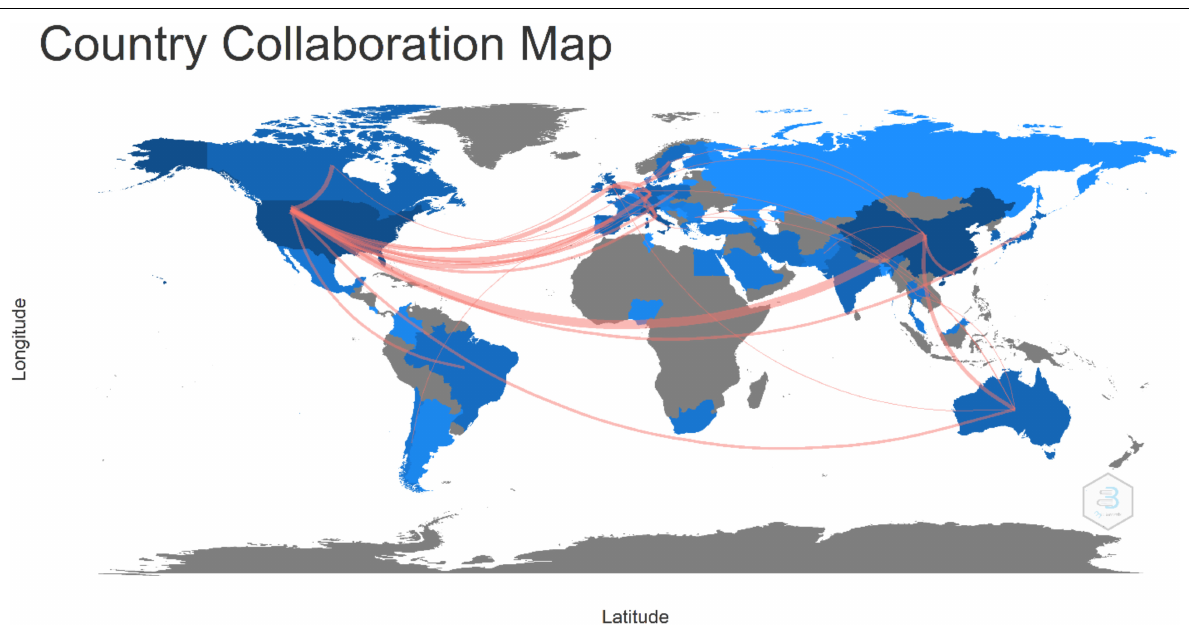
FIGURE 6 | International collaborations among countries. The pink color line represents the connection between countries and its thickness identifies the degree of collaboration. The thicker the line the stronger the collaboration